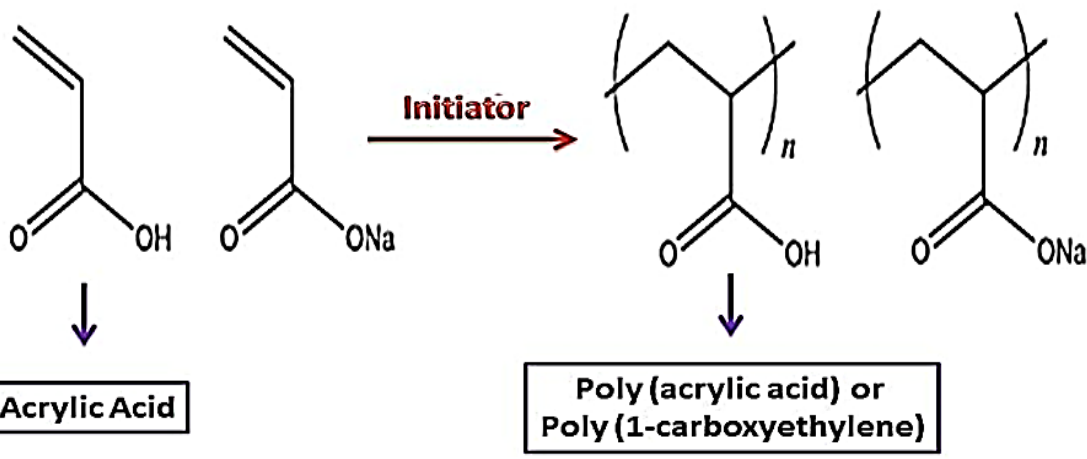
Figure 4. Synthesis and chemical structure of poly sodium acrylate (NaPAA) and PAA, adapted from [126], MDPI, 2020.